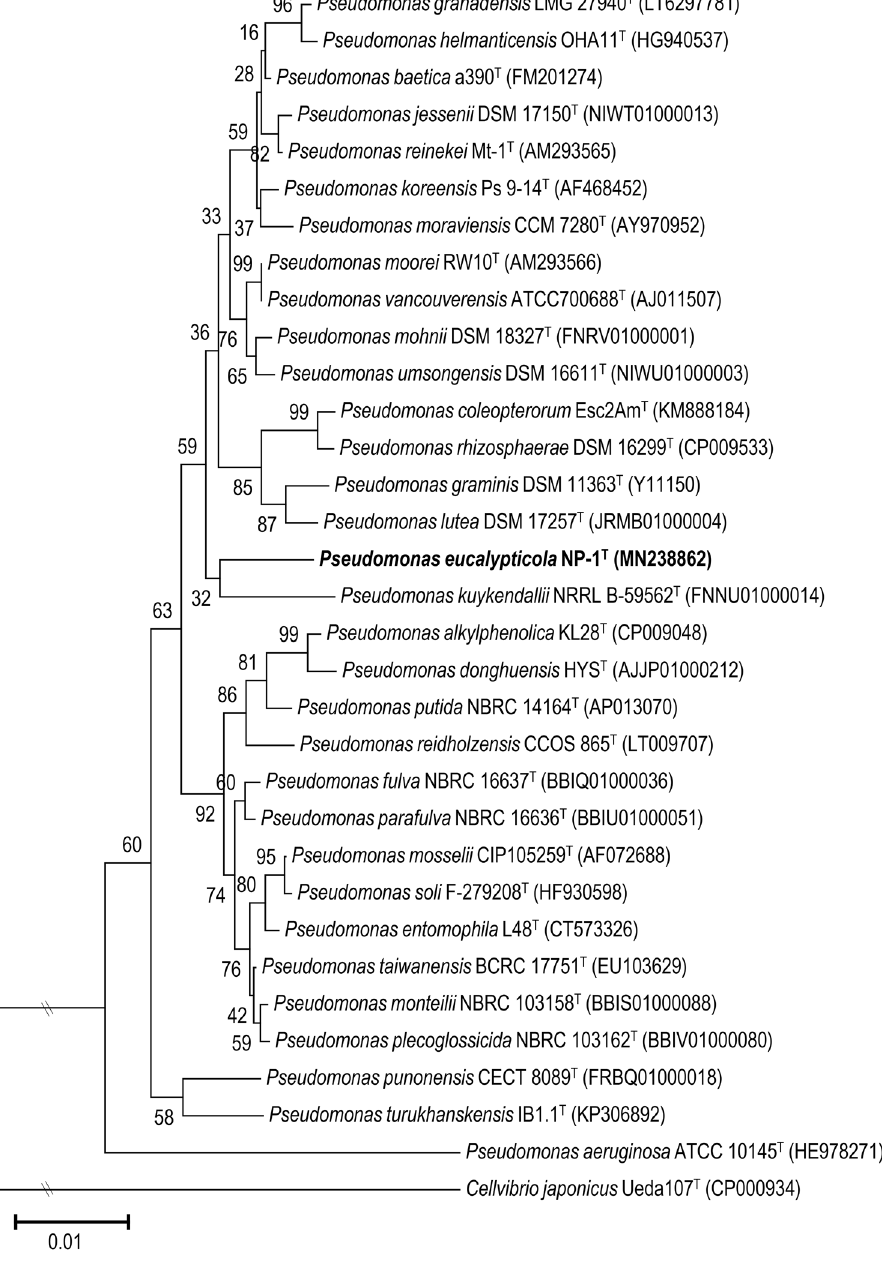
Figure 1. Neighbor-joining phylogenetic tree based on the 16S rRNA gene of Pseudomonas eucalypticola NP-1 T and phylogenetically close members of Pseudomonas . The evolutionary distances were computed using the Jukes-Cantor method. The optimal tree with a sum of branch length = 0.23535266 is shown. The percentage